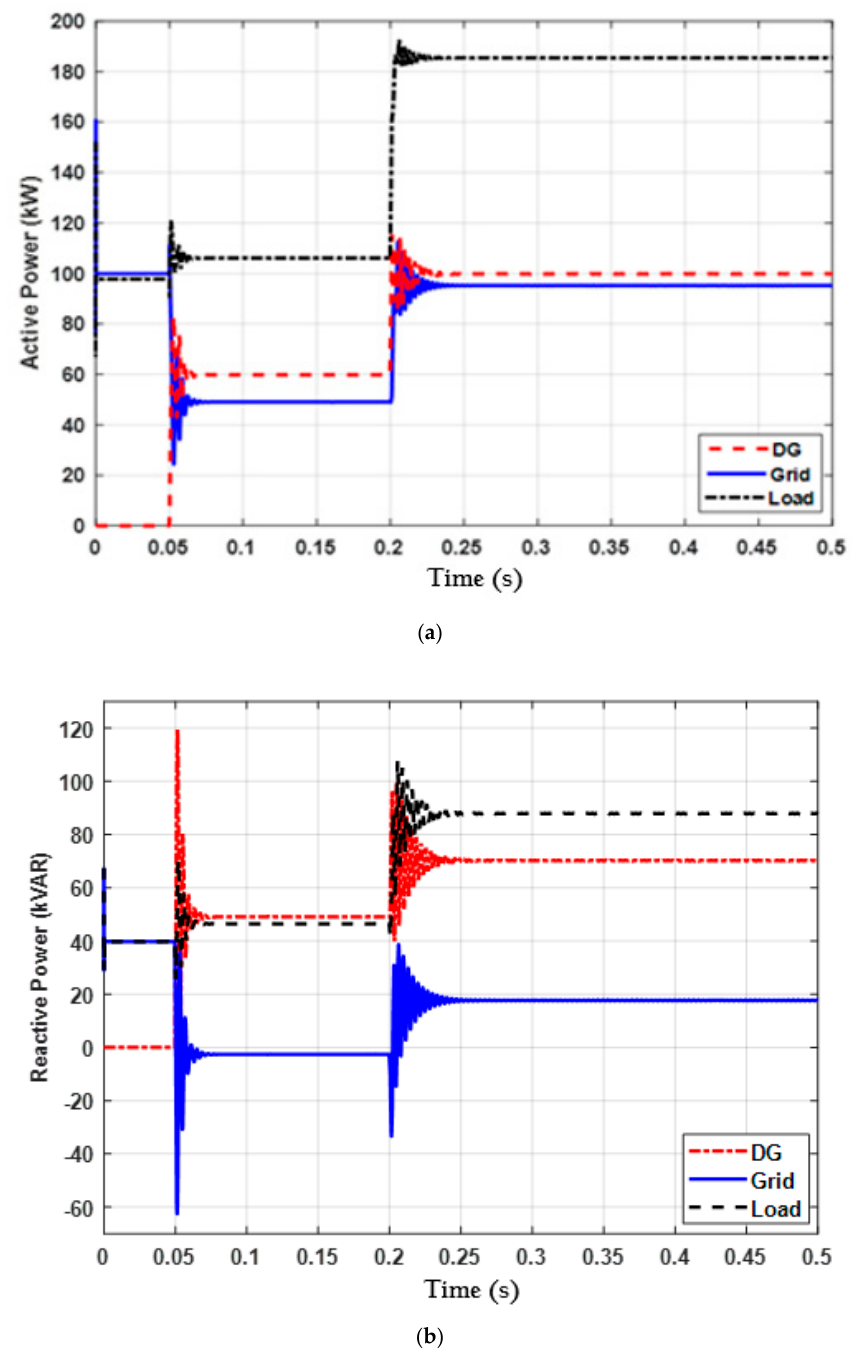
Figure 7. ( a ) Active power ( b ) Reactive power flow between the MG and utility grid.